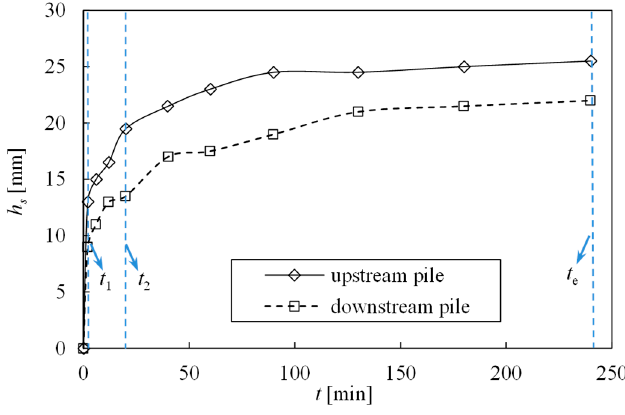
Figure 2. Temporal development of the maximum scour depth.